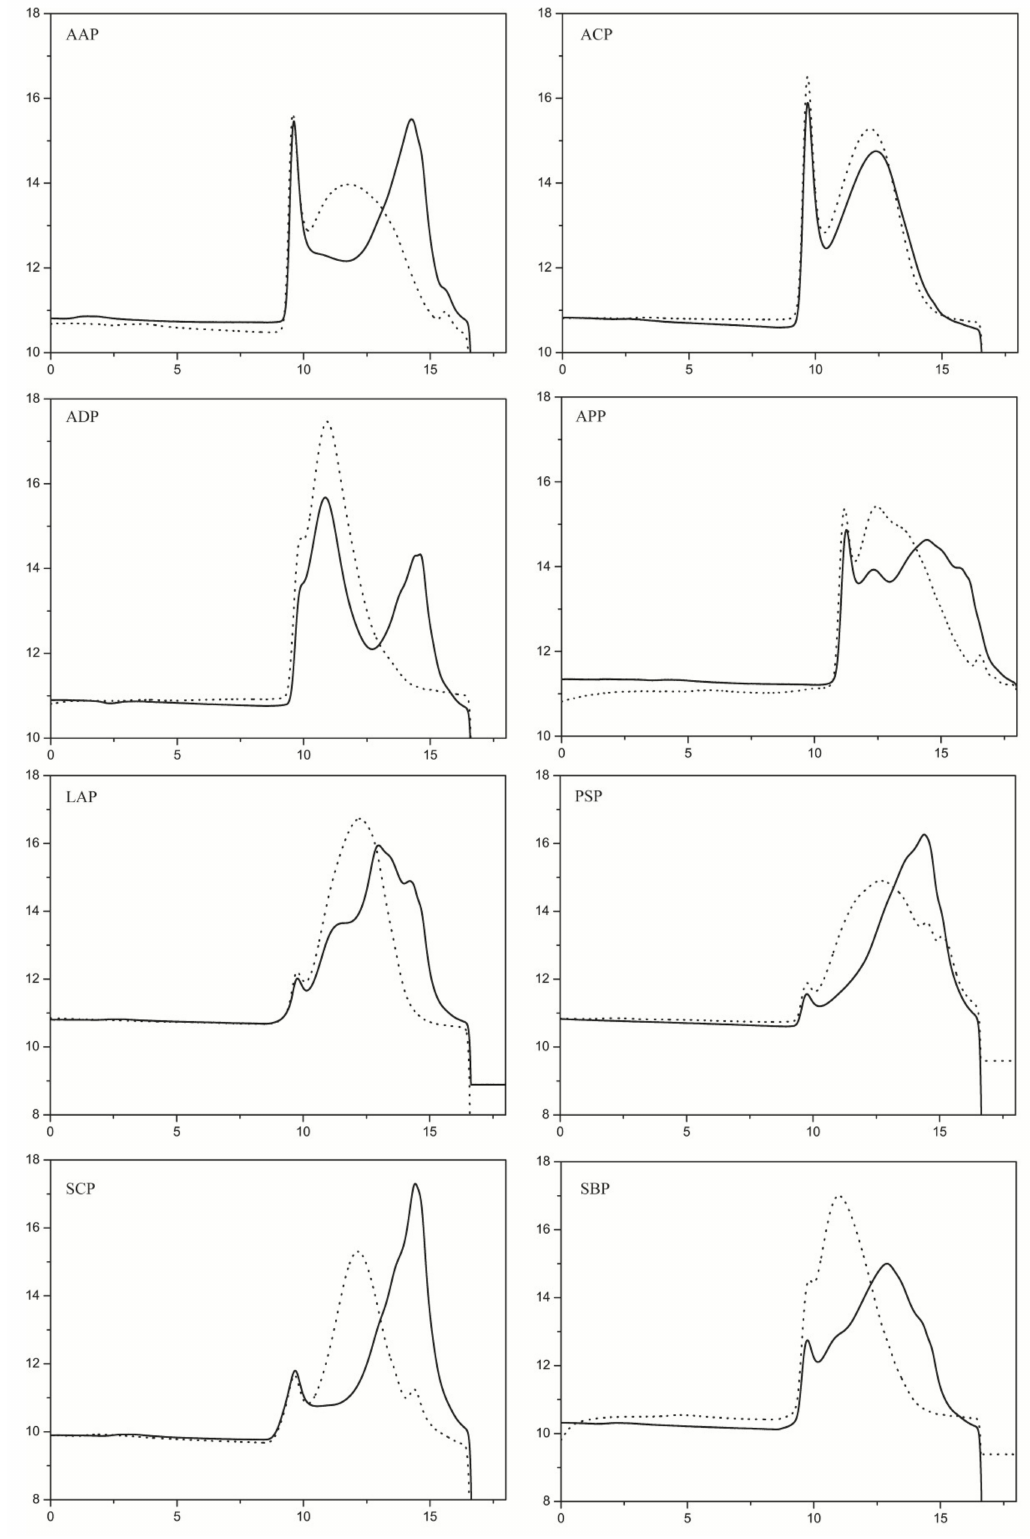
Figure 6. High-performance gel permeation chromatography (HPGPC) analysis of degradation of pectins from di ff erent plants by PpPel9a. Dash line represents the substrate and solid line represents the degradation